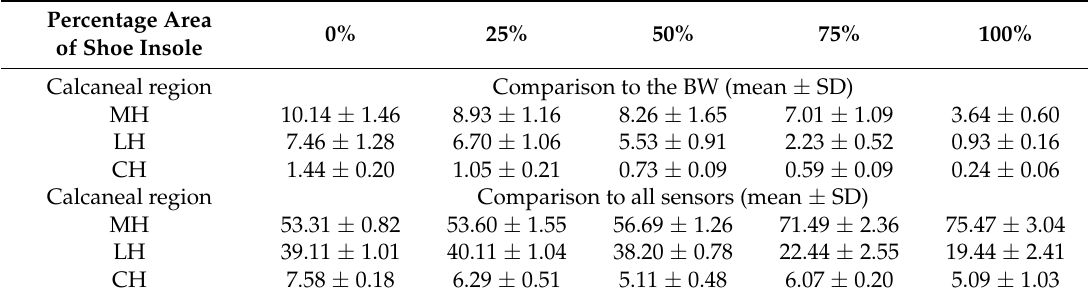
Figure 5. Example of negative casts of the foot from one subject. Table 4. Comparison of load of each sensor to the BW and all sensors